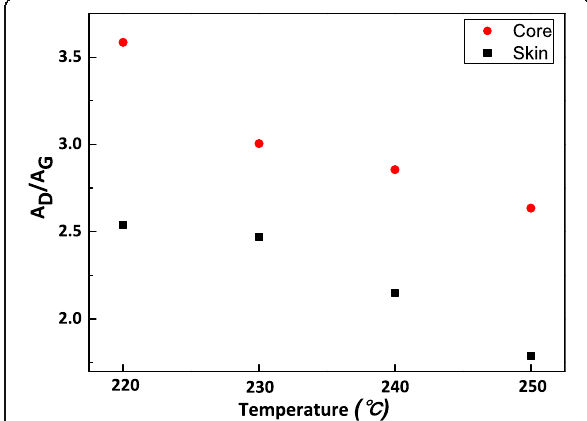
Fig. 5 The A D / A G value in skin and core regions of fibers with respect to treatment temperature from 220 °C to 250